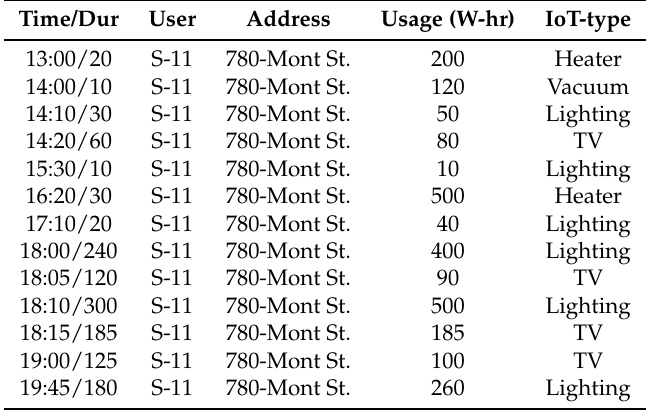
Table 2. Anonymized power consumption data in service group